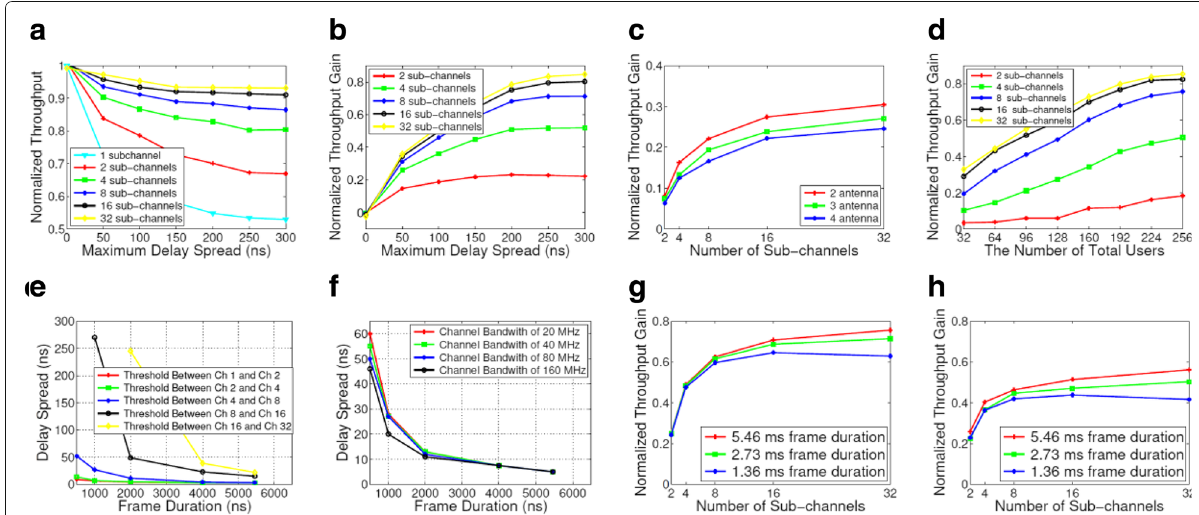
Fig. 12 Experimental results with either emulated or actual wireless channels on 5.2 GHz. a Normalized throughput for different number of sub-channels across channel delay spreads. b Normalized throughput gain for different number of sub-channels across channel delay spreads. c Normalized throughput gain versus antenna numbers on the AP for 2 selected users. d Throughput gain versus the number of total users in the coverage of the AP. e Sub-channel division threshold changes with frame duration. f Sub-channel division threshold changes with channel bandwidth. g Normalized throughput gain in emulated IEEE TGn channel model. h Normalized throughput gain in an actual office